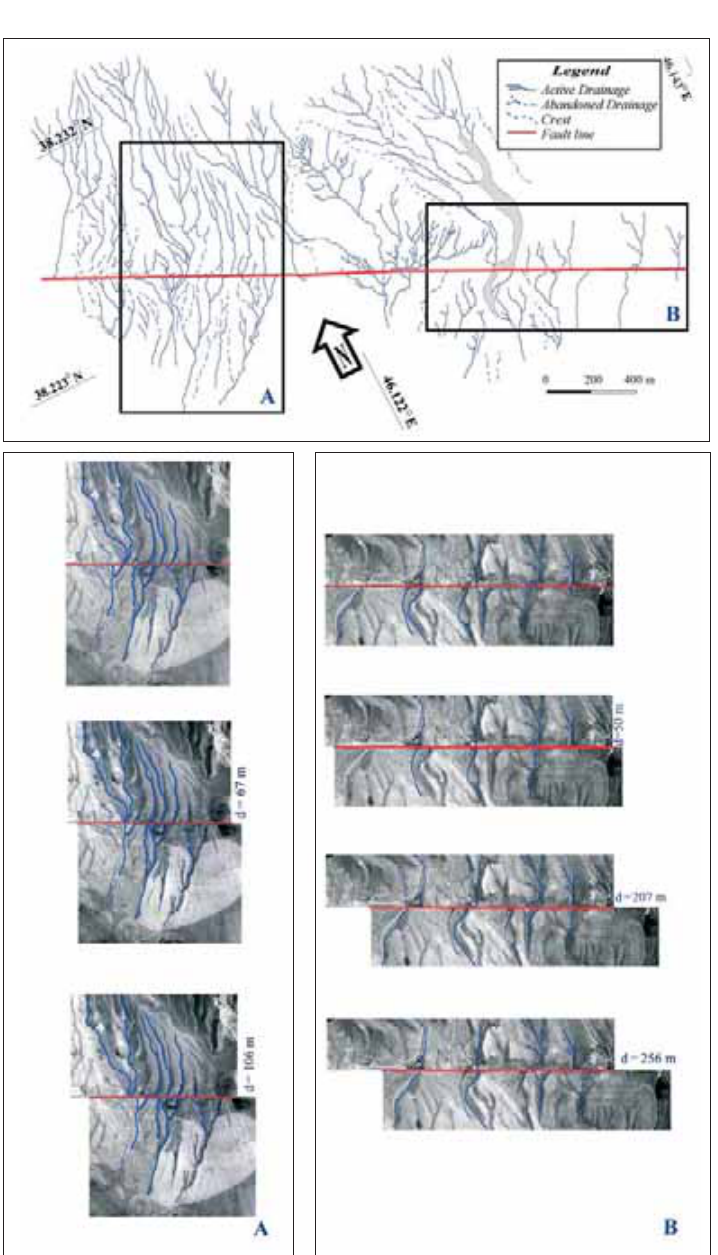
Fig. 4. Offsets of stream beds along the North Tabriz Fault. A and B show aerial photographs (1:10 cumulative right-lateral displacements along the NW section of the North Tabriz Fault. Top photographs in A and B represent present-day configuration of rivers and stream beds. Lateral offsets of the same geomorphic lev- els are recognized by reconstructing previous steps of deformation during the Late Pleistocene (top to